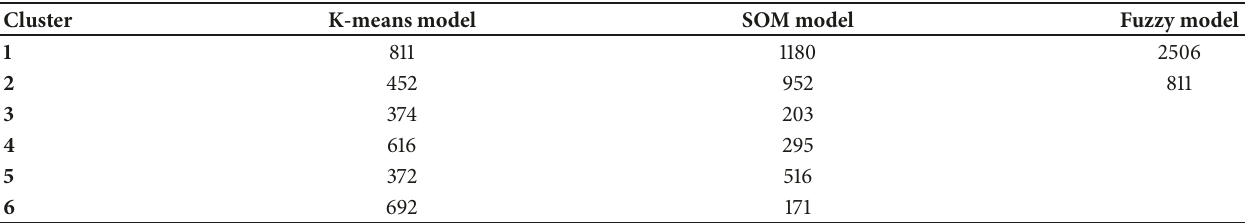
Table 3: Cluster densities (number of households allocated to the cluster) for the Tanzania dataset. Cluster K-means model SOM